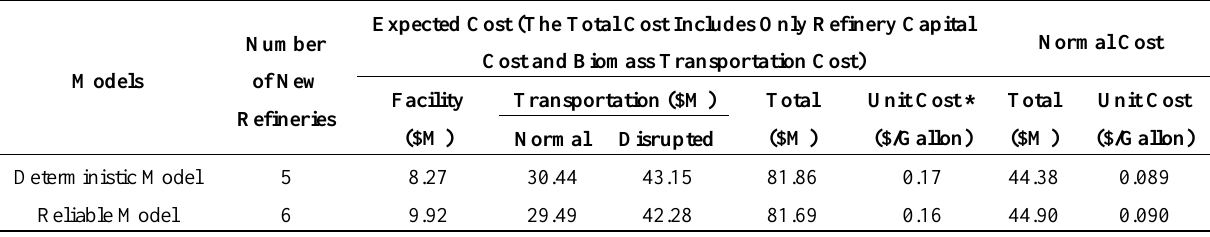
Table 2. Comparison between the deterministic and reliable